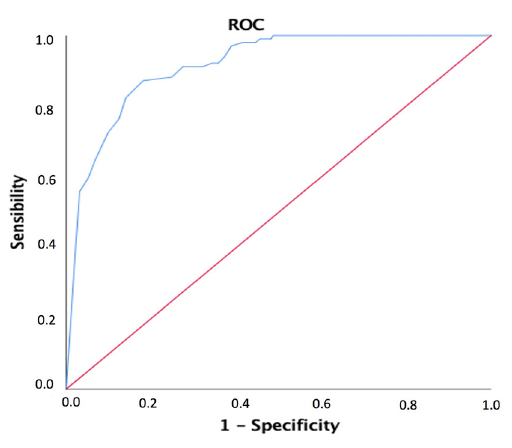
Figure 1. ROC curve used to determine the predictive value of the CPTO in determination of students with excellent skills. Table 4. Mean scores in students with and without excellent professional skills.